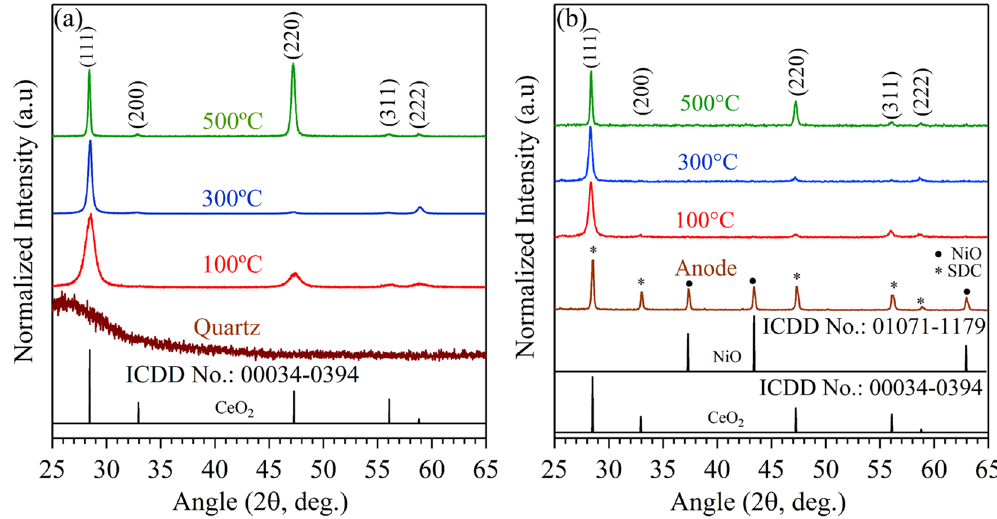
Figure 1. B-B geometry XRD pattern of the thin film deposited at substrate temperatures of 100, 300 and 500 °C over Quartz ( a ) and Anode ( b ).